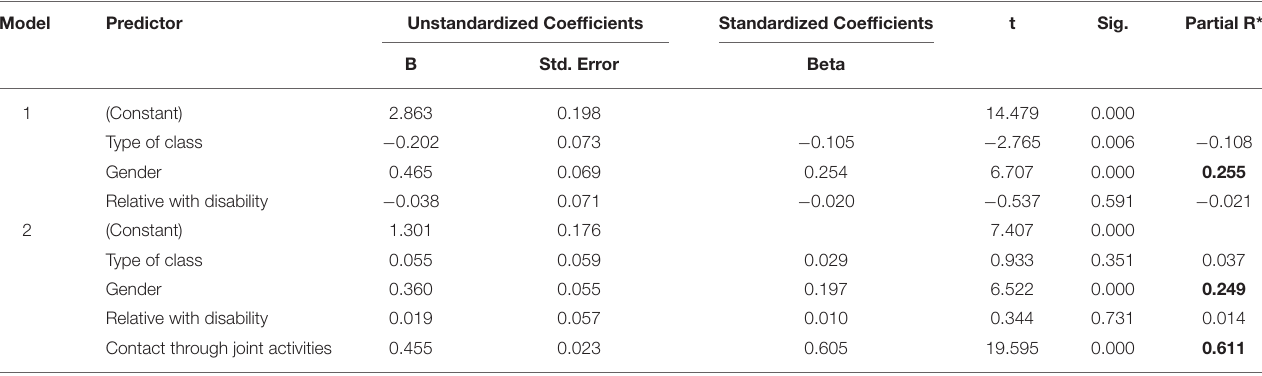
TABLE 2 | Multiple regression models to predict students’ attitudes (CATCH) n = 652. Model